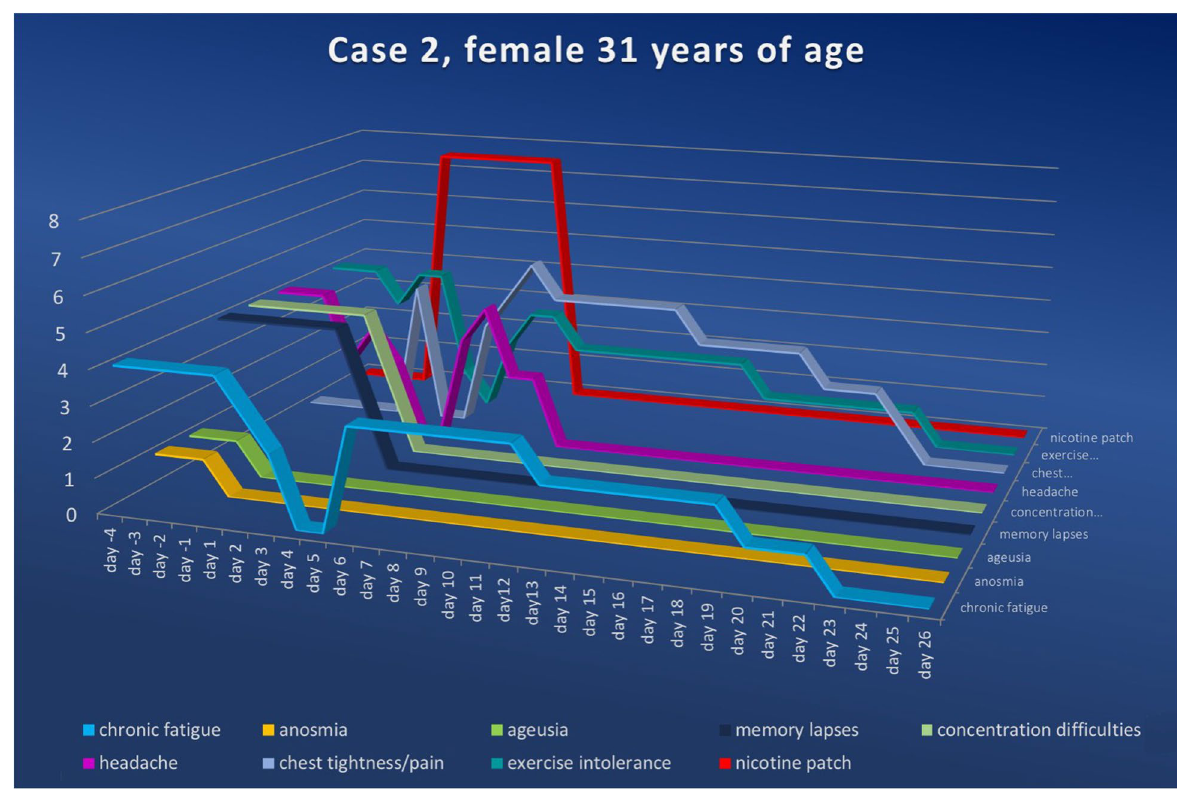
Fig. 4 Symptom score for case 2 ranging from the fourth day prior to and to the twenty-sixth day after nicotine administration (fourth symptom-free day). Upon nicotine treatment, the symptom scores in all categories fell continuously. The numerical value in the ordinate shows the value of the symptom score, while the nicotine dosage for the amount delivered per 24 h is shown in